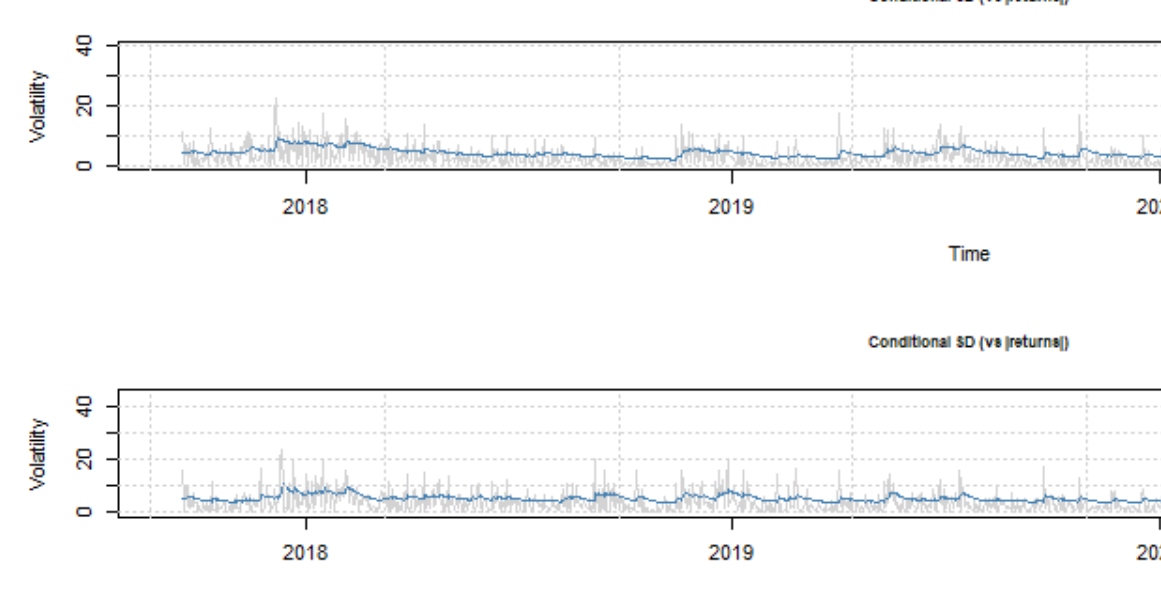
Figure 5. Volatility plots with Bitcoin atop followed by Ethereum and lastly JSE